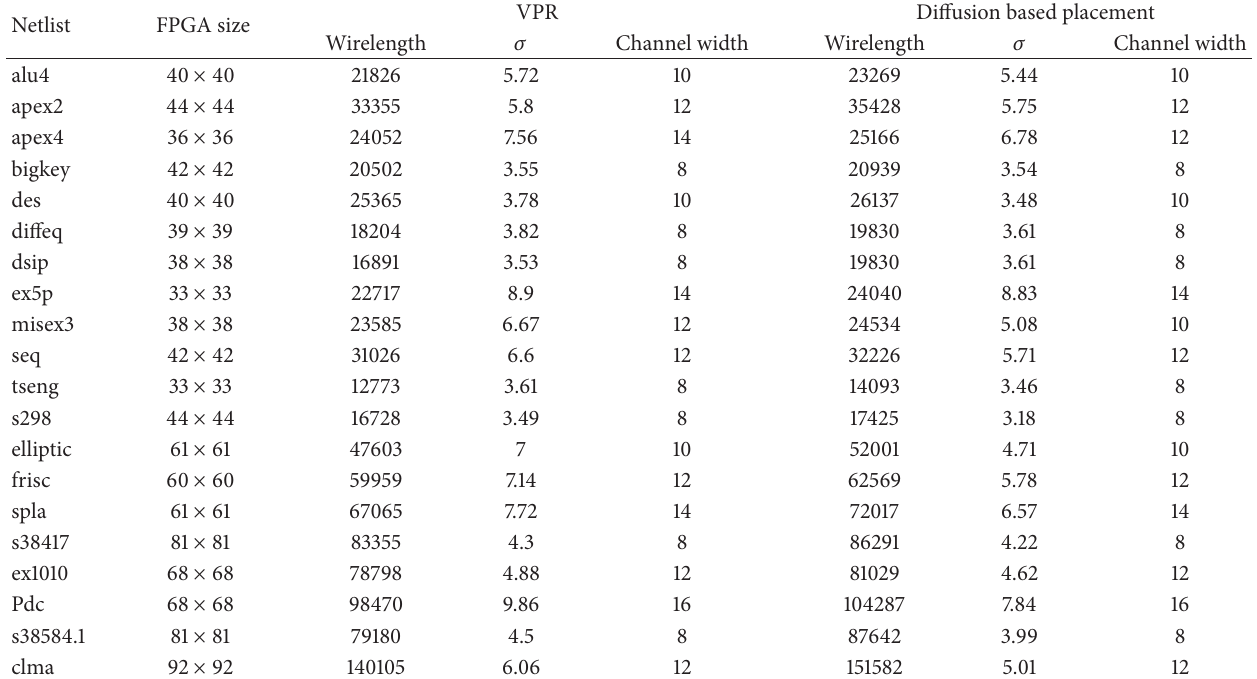
Table 1: Results produced by VPR for cluster size 𝑁 = 1 .